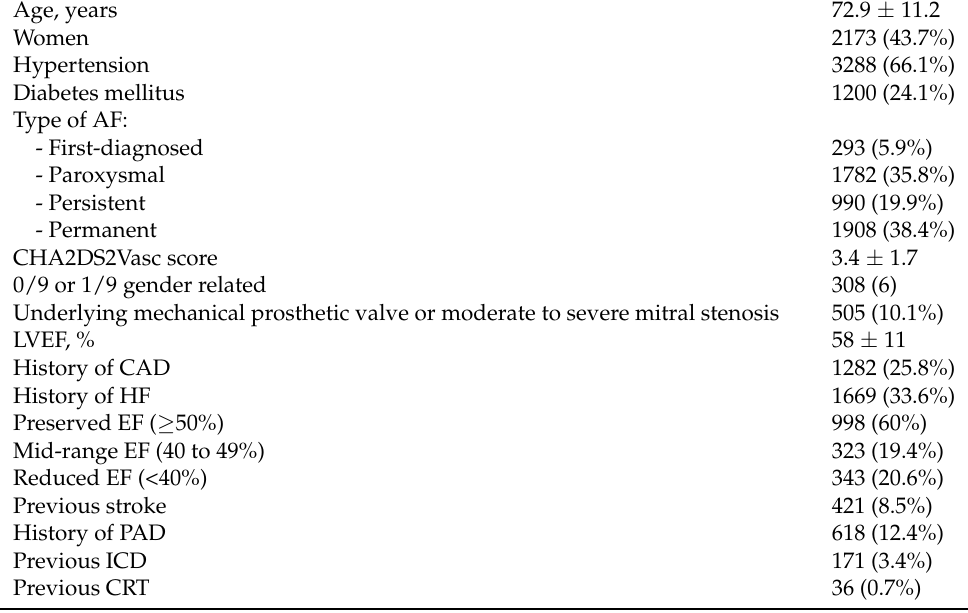
Table 1. Baseline characteristics of the study population ( n =